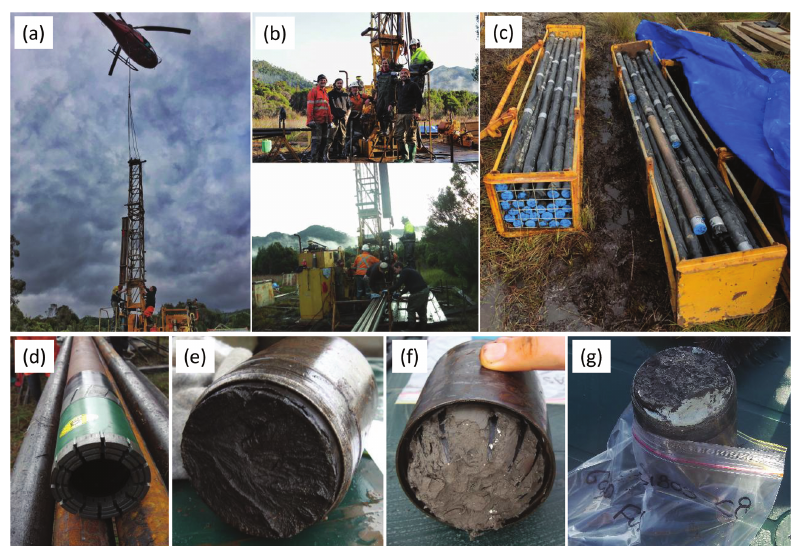
Figure 2. Photos of TAS1803 scientific drilling at Darwin Crater. (a) Helicopter-assisted drill rig assembly. (b) The drill team and view of the drilling and core handling set-up. (c) After recovery, the cores were immediately wrapped in black plastic to protect from light to allow for OSL dating. (d) The drill bit, (e) core end view from the top, (f) core end view from the base, together with the core catcher, and (g) core end sample C8 includes a white mineral tentatively identified as vivianite.